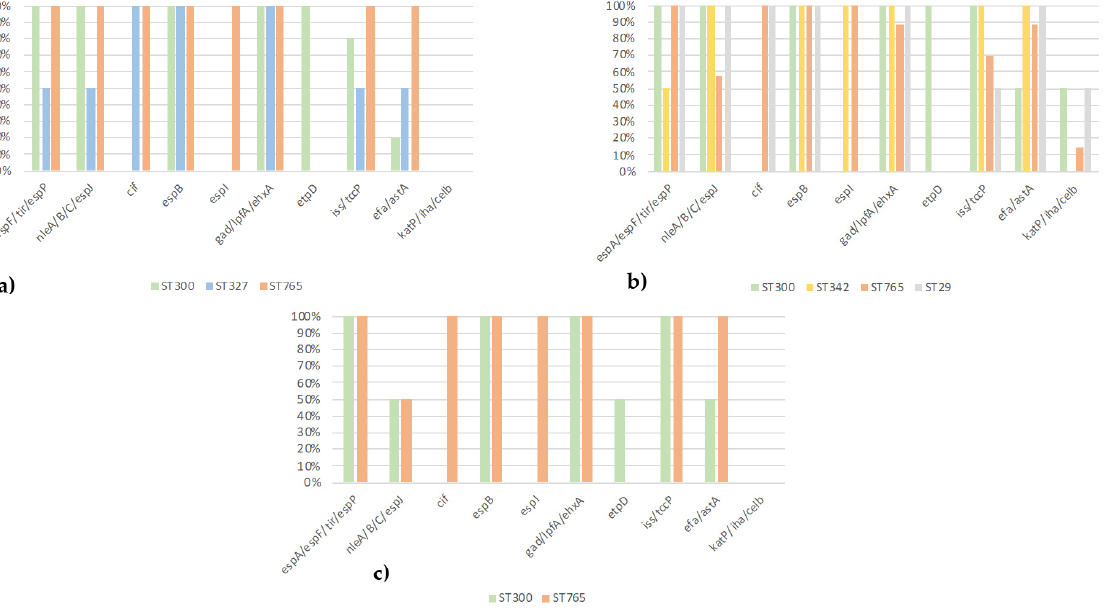
Figure 1. MLST prevalence by virulotyping in EPEC; ( a ) healthy cattle, ( b ) diarrheic calves, and ( c ) healthy calve